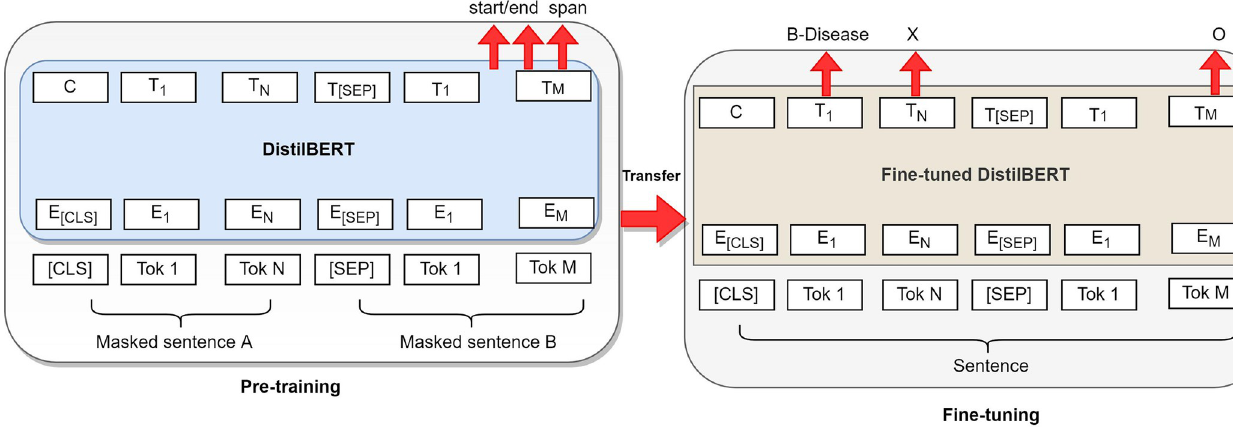
Fig 4. Model adaption from the teacher model to the student